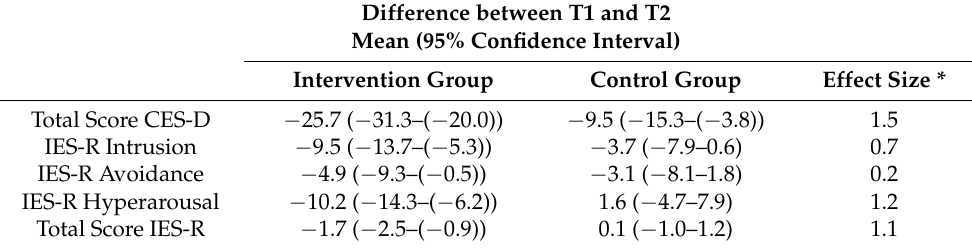
Table 3. Mean differences of the total CES-D Scores and the total and subcategories IES-R Scores of mothers of preterm infants born < 32 gestational weeks with and without music therapy between assessment one week after birth and the infant’s discharge.